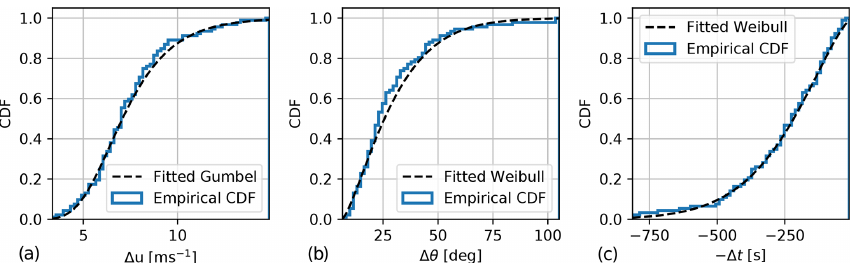
Figure 1. The marginal fitted and empirical cumulative distributions of gust amplitude (a) , gust direction change (b) , and negative gust rise time (c) .